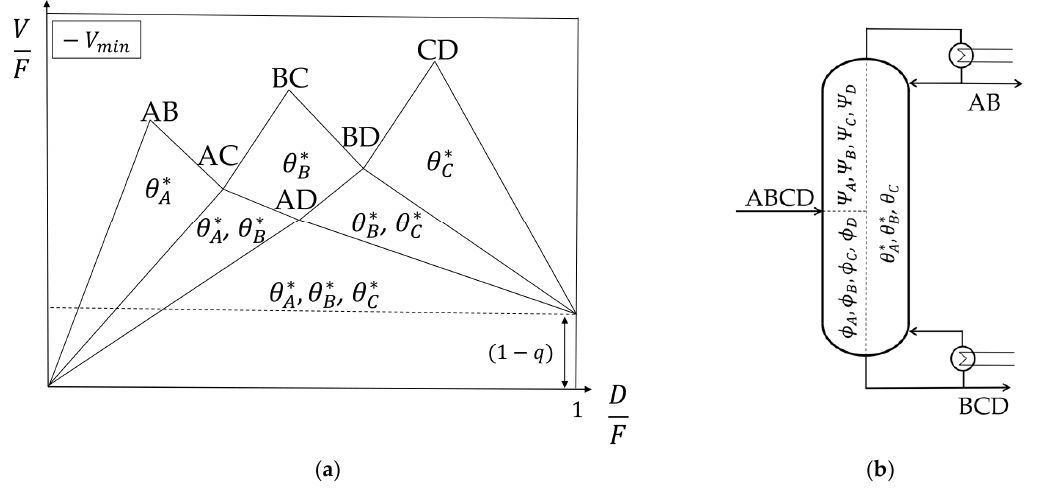
Figure 3. ( a ) Active roots during different splits shown in V min diagram of a four component mixture (modified after [10]) and ( b ) different kinds of Underwood Roots in a distillation column for a sharp AC split and four components